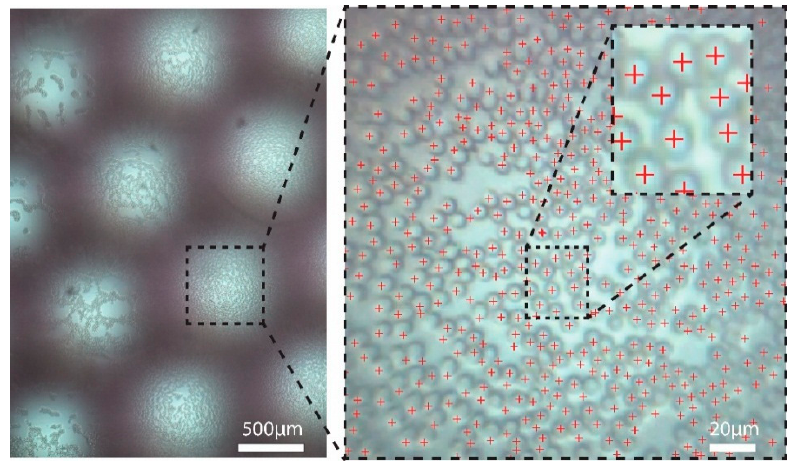
Figure 4. Image of a whole blood smear test captured with our system Automated, single cell identification was made possible using a MATLAB algorithm of image enhancement and